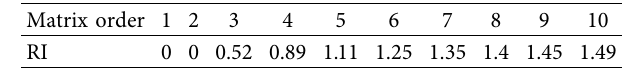
Table 3: RI’s control